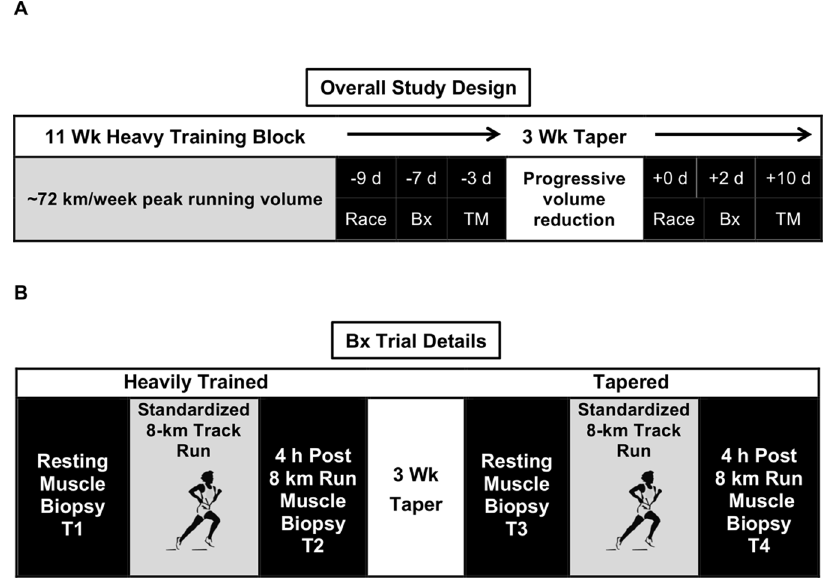
Figure 1. Overall study design (A), and Biopsy trial details (B). Bx=lateral gastrocnemius muscle biopsy, TM=Treadmill VO 2max testing.